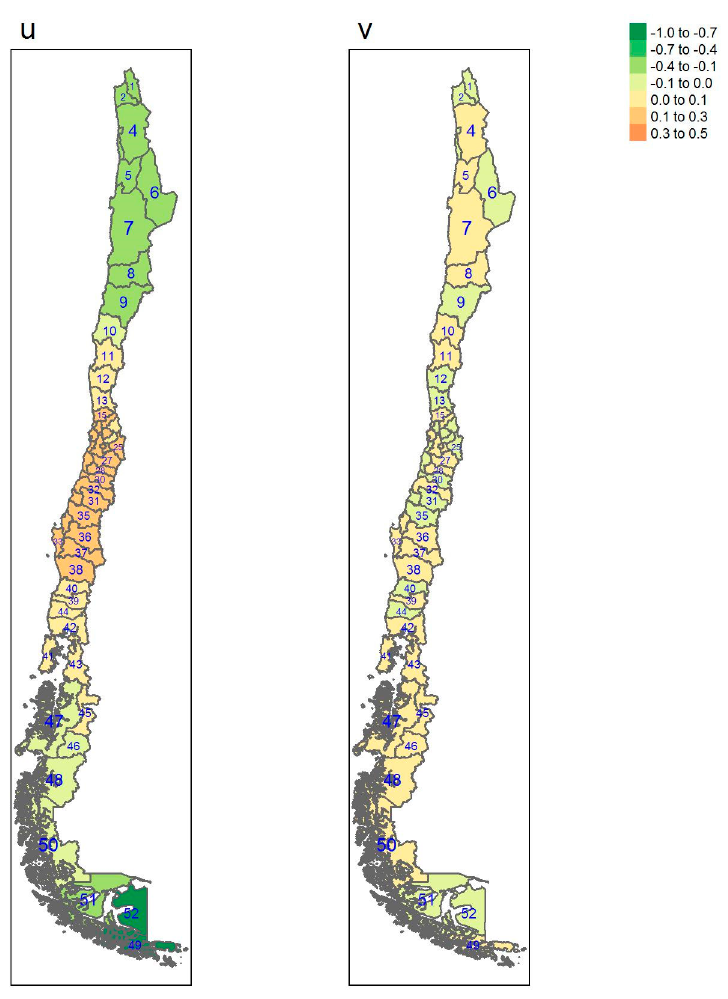
Figure 3. Multi-scale model heterogeneity effects for hypertension (u: correlated effect; v: uncorrelated effect).